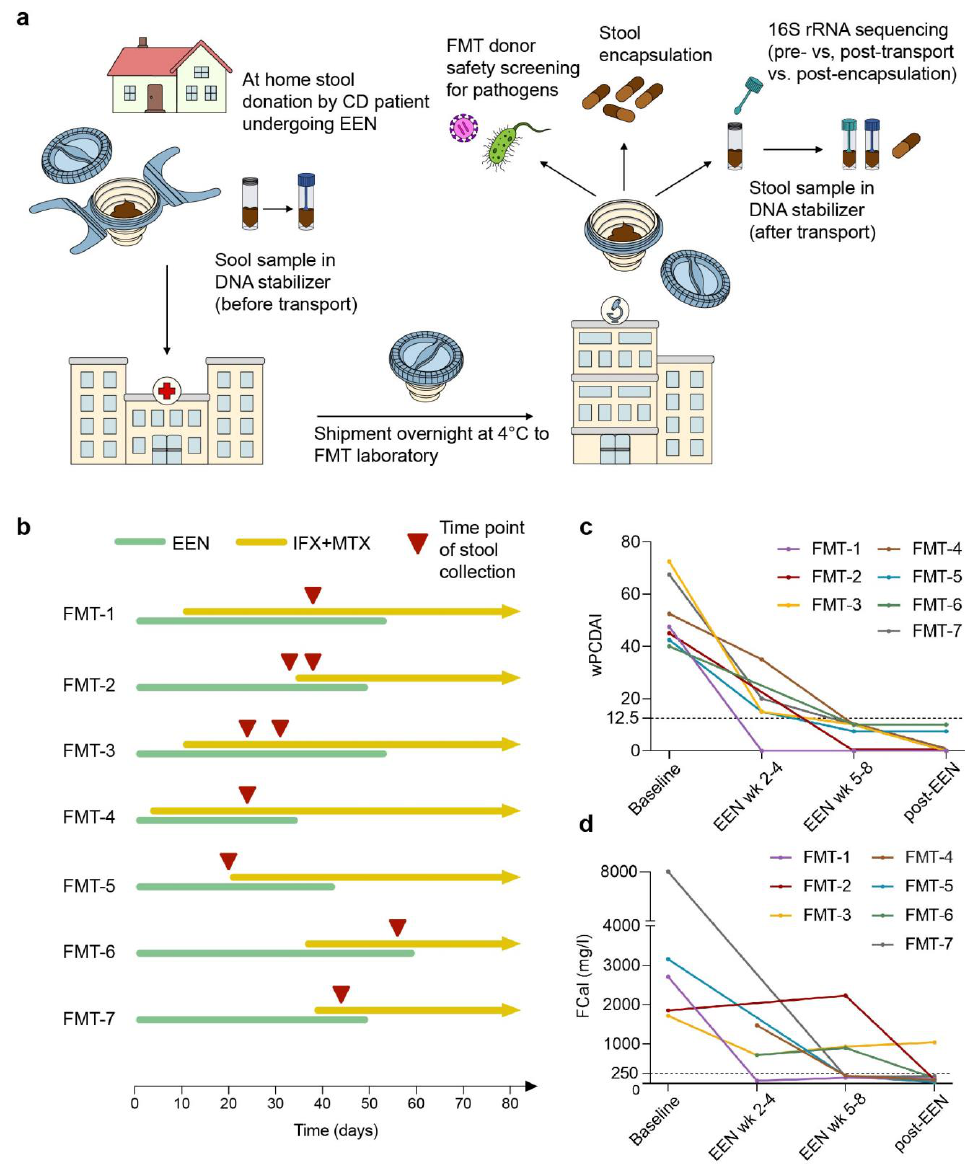
Figure 1. Clinical course of study participants and time point of stool donation. ( a ) Study design. Study participants were asked to donate stool at home during EEN treatment. After immediate transport to the clinic at 4 °C, Fecotainers were packed and shipped overnight at 4 °C to the GMP- certified FMT laboratory. Stool donations were then analyzed for fecal mass and stool consistency; a comprehensive FMT donor safety screening for pathogens was performed; and FMT capsules were produced. ( b ) Illustration of treatment periods and time points of stool donation for FMT capsule production. Green: induction therapy with EEN. Ochre: maintenance therapy with IFX and MTX. Red triangle: time point of stool collection. ( c ) Weighted PCDAI (wPCDAI) scores of study participants at baseline, at weeks 2–4 of EEN (EEN week 2–4), at weeks 5–8 of EEN (EEN week 5–8), and 1–2 weeks after completion of EEN (post-EEN). ( d ) Fecal calprotectin (FCal) concentrations of study participants at baseline, at weeks 2–4 of EEN (EEN week 2–4), at weeks 5–8 of EEN (EEN week 5–8), and 1–2 weeks after completion of EEN (post-EEN). Test for significance was performed using a one-way ANOVA with Tukey ´ s multiple comparisons test (confidence level of 95%; definition of statistical significance: p < 0.05). Abb.: CD = Crohn’s disease; EEN = exclusive enteral nutrition; FCal = fecal calprotectin; FMT = fecal microbiota transfer; IFX = infliximab; MTX = methotrexate; wk = week; wPCDAI = weighted pediatric Crohn’s disease activity